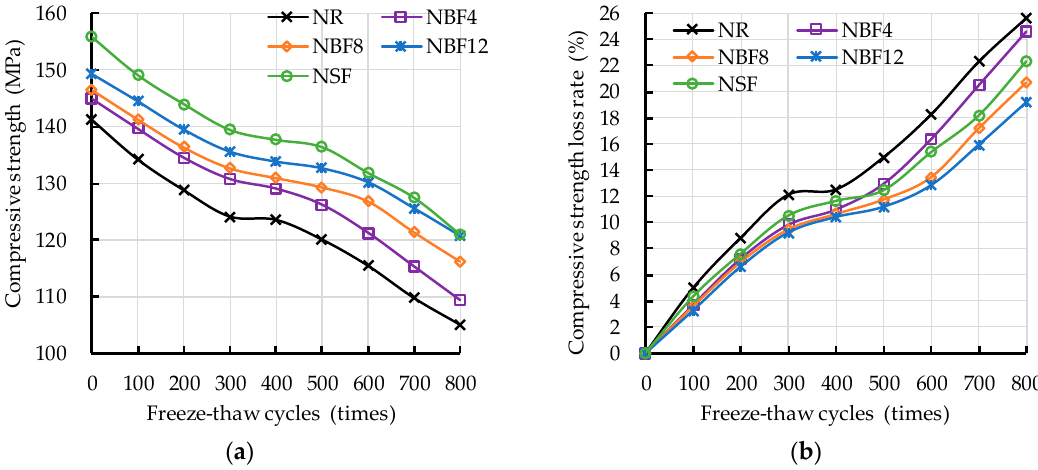
Figure 7. Compressive strength and compressive strength loss rate versus freeze – thaw cycles: ( a ) Compressive strength; ( b ) Compressive strength loss rate. ( a ) Compressive strength; ( b ) Compressive strength loss